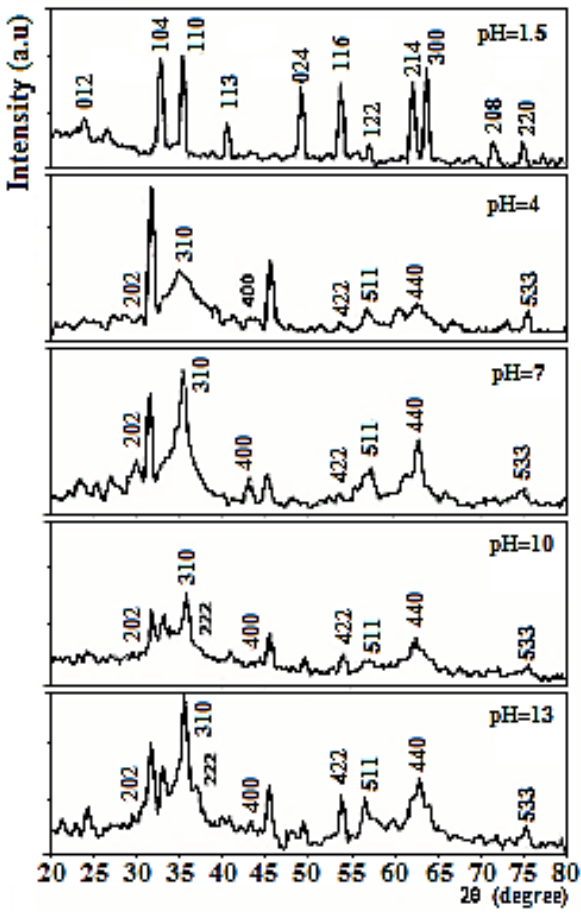
Figure 1: XRD patterns of prepared samples at different pH.